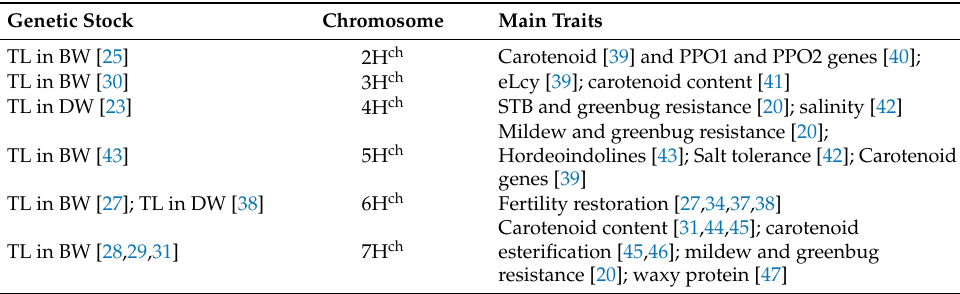
Table 2. Translocation lines (TL) of H. chilense in bread wheat (BW) and durum wheat (DW). Genetic